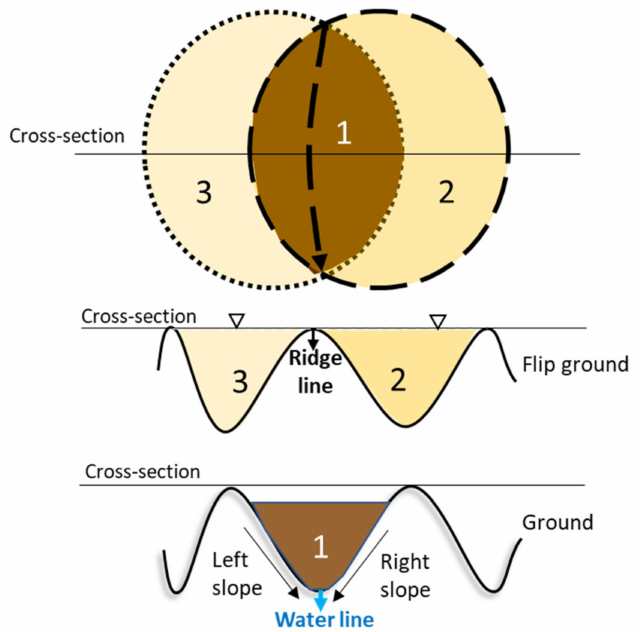
Figure 2. Schematic of dividing the slope units with the overlap method of catchment areas (modified from